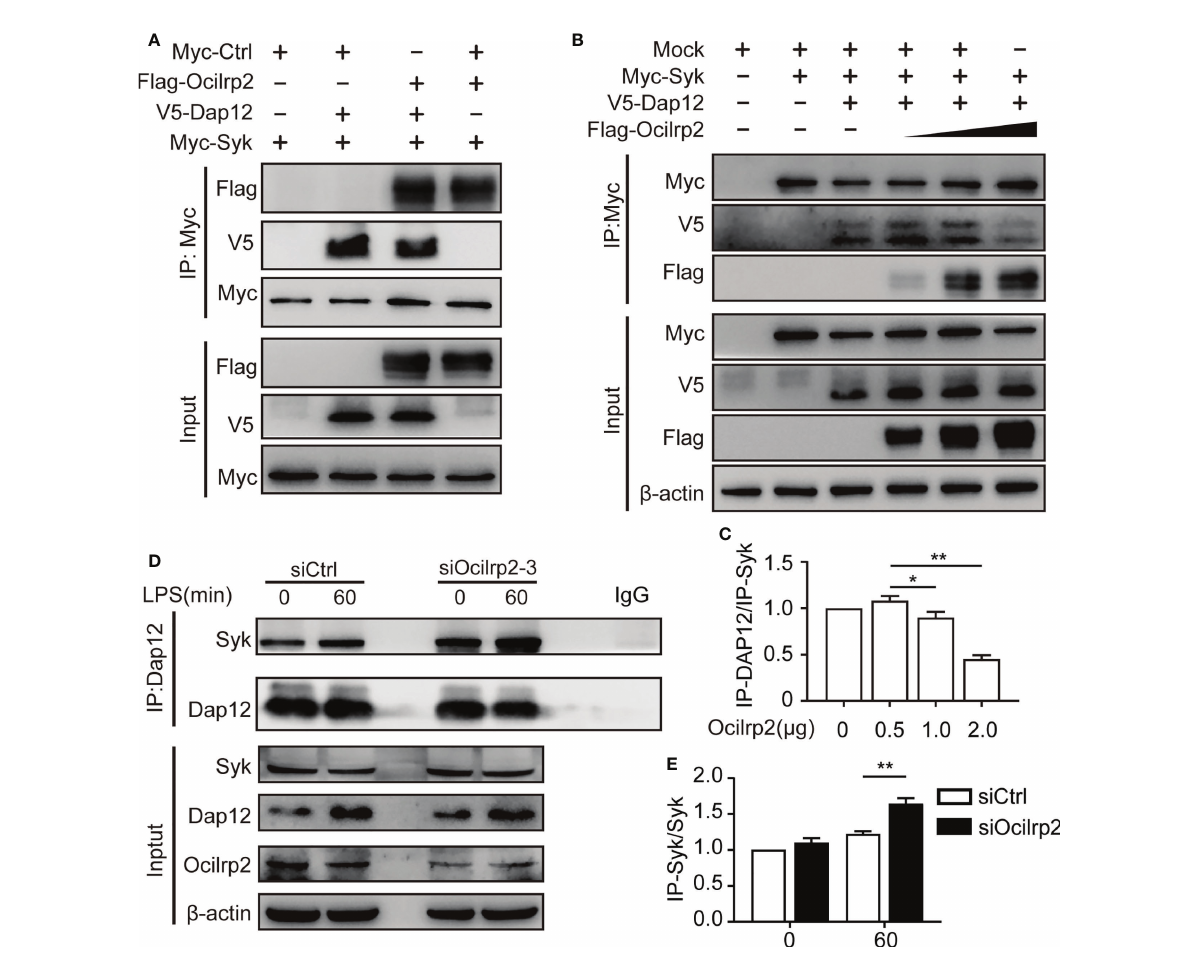
FIGURE 6 Ocilrp2 blocks the association of DAP12 and Syk. (A) HEK293T cells were transfected with Flag-Ocilrp2, Myc-Syk, and V5-Dap12 for 48 h. Cell lysates were immunoprecipitated with anti-Myc antibody and analyzed by immunoblot using anti-Flag, anti-V5, and anti-Myc antibodies. (B) HEK293T cells were transfected with mock, Myc-Syk, V5-Dap12, and different concentrations of Flag-Ocilrp2. At 48 h post-transfection, transfected cells were extracted, and cell lysates were subjected to immunoprecipitation with an anti-Myc antibody followed by immunoblotting using anti-Myc, anti-V5, and an anti-Flag antibody. (C) Densitometric quanti fi cation of the ratio of Dap12. Data were analyzed by three independent experiments. (D) Mouse peritoneal macrophages were transfected with siCtrl or siOcilrp2 and then incubated with or without LPS for 1 h. Cell lysates were immunoprecipitated with anti-Dap12 antibody and analyzed by immunoblot using the indicated antibodies. (E) Densitometric quanti fi cation of the ratio of Dap12. Data were analyzed by three independent experiments (means ± s.e.m). Signi fi cant differences compared to the control group are denoted by * P < 0.05, ** P < 0.01 (two-tailed Student ’ s